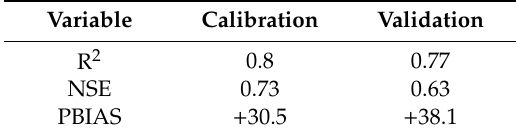
Table 5. Streamflow calibration and validation results (monthly) at the Logiya outlet gauging station